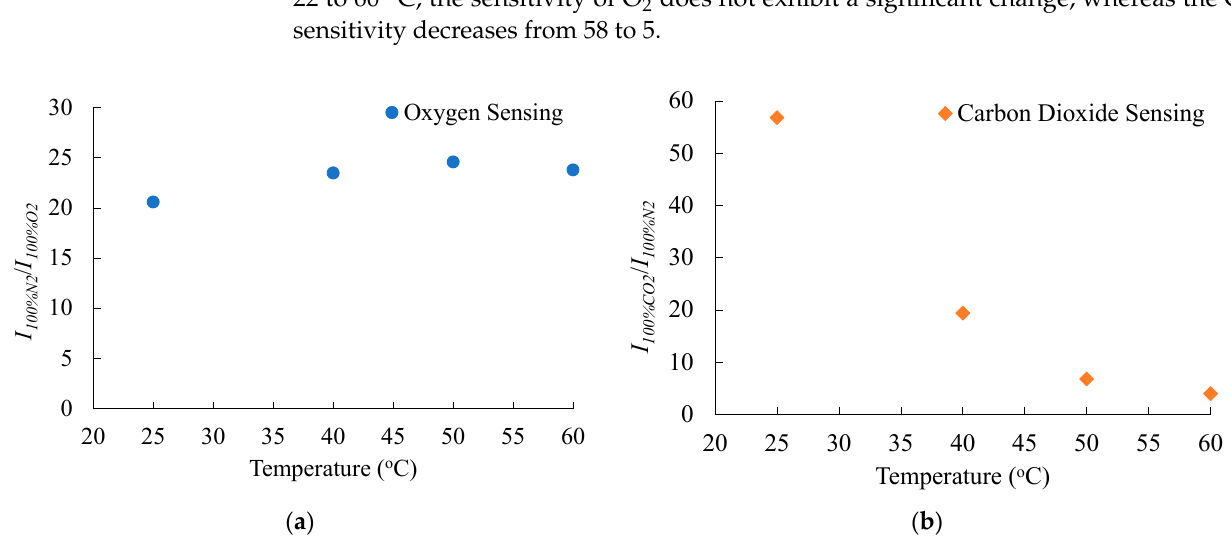
2 and ( b ) CO 2 of the optical dual